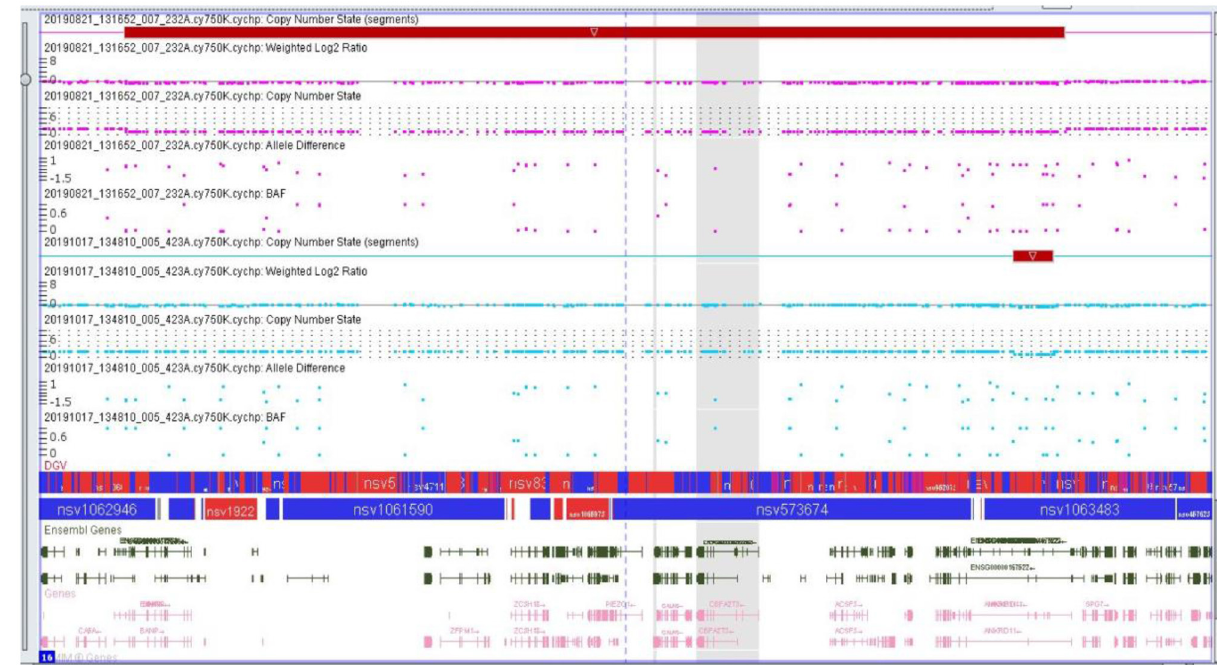
Frontiers in Pediatrics |